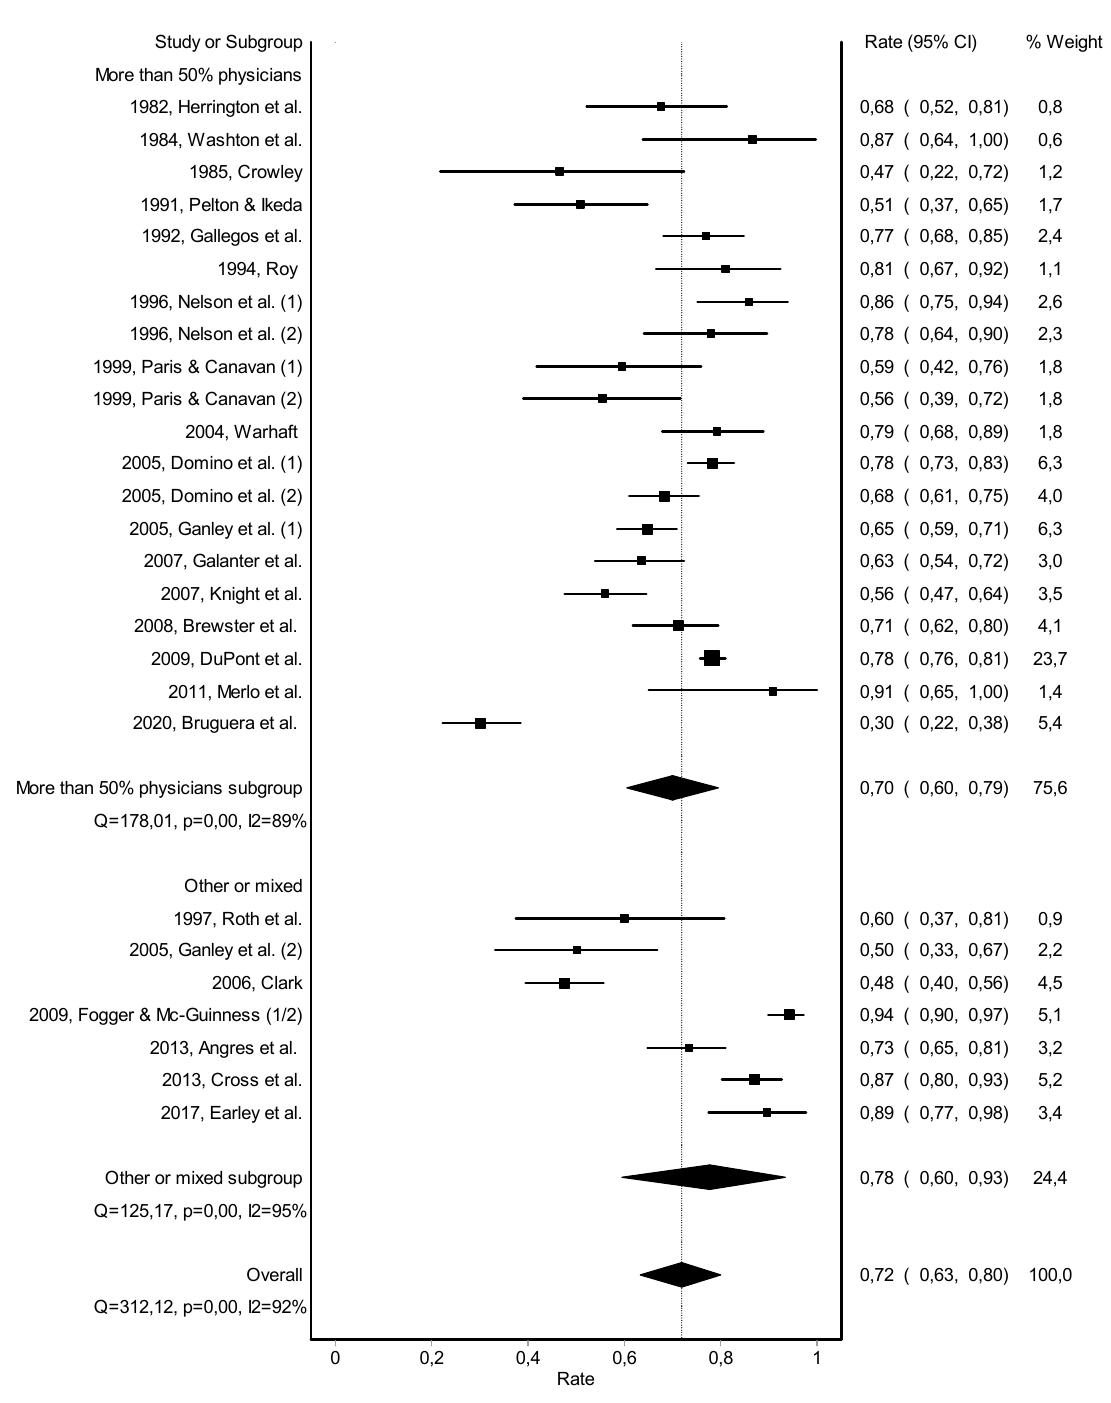
Figure A4. Forest plot of the pooled abstinence rate—subgroup analysis based on type of healthcare professional.